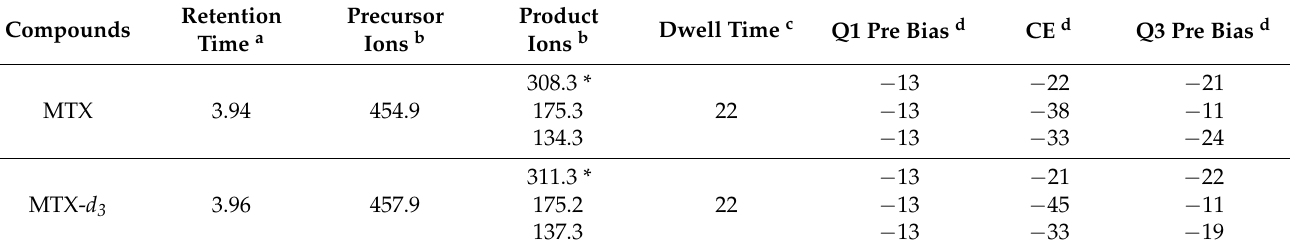
Table 1. UHPLC–ESI-QqQ-MS/MS parameters for MTX and MTX- d 3